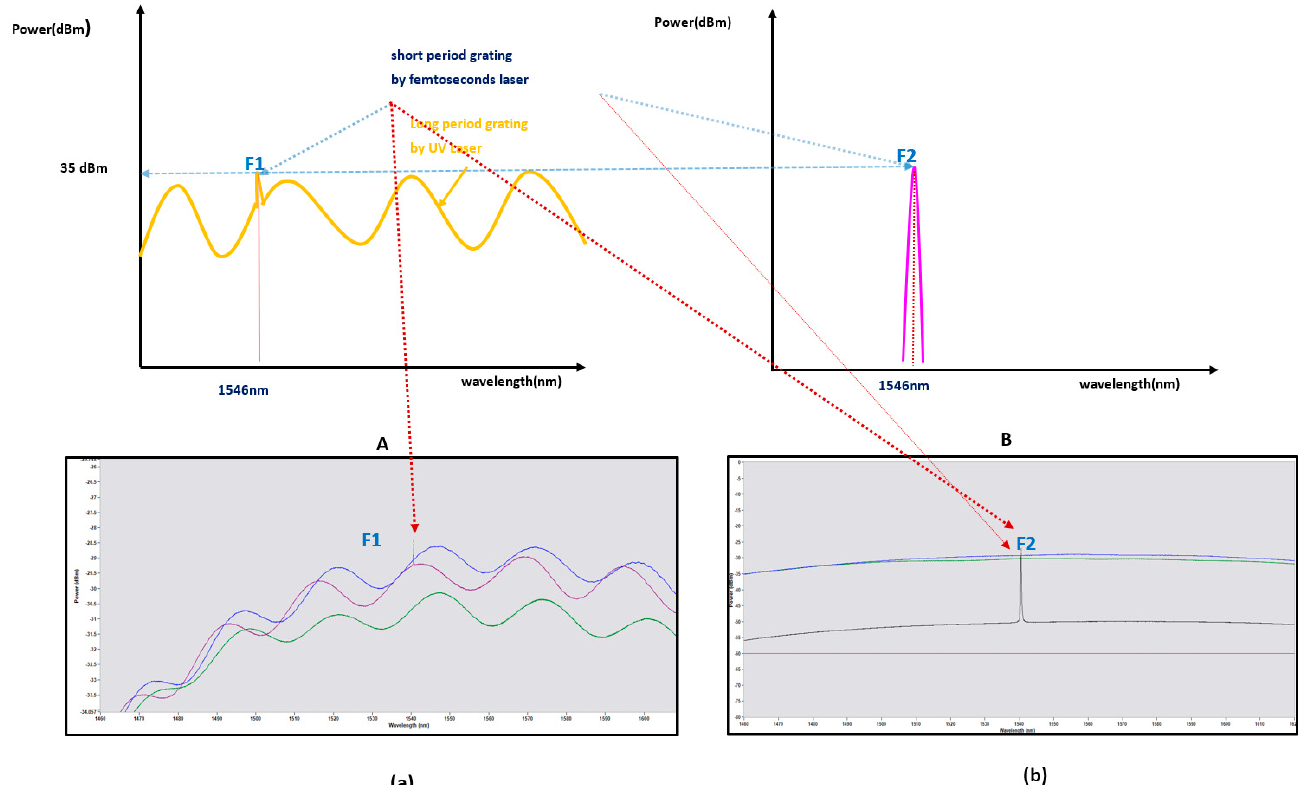
Figure 7. ( A ) One short-period Bragg grating spectrum between long-period gratings; (a) A ’s morphology picture measured on an actual interrogator monitor; ( B ) Bragg grating spectrum with only short-period gratings; (b) B ’s morphology picture measured on an actual interrogator monitor.